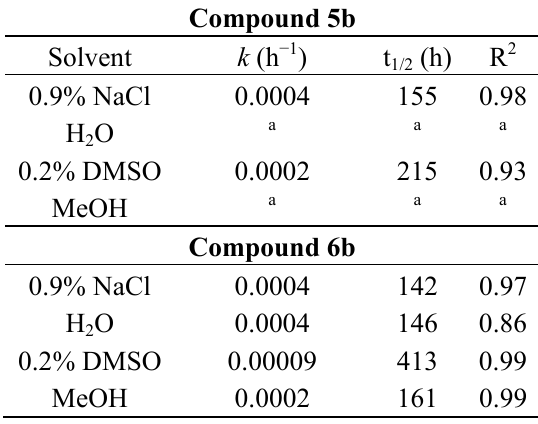
Table 3. Degradation kinetic parameters in tested